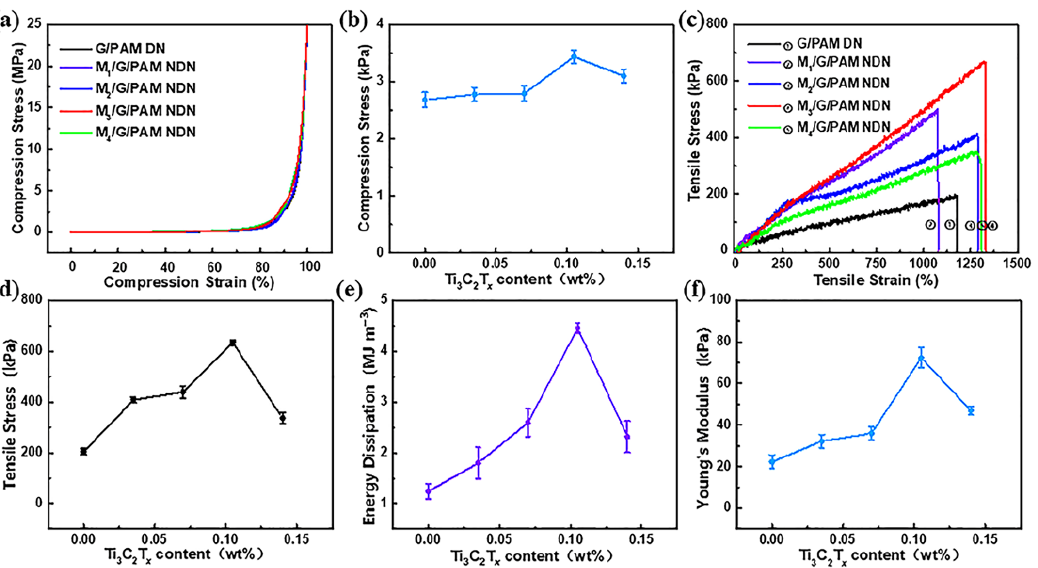
Figure 2. Comparison of ( a ) compressive stress–strain curves, ( b ) compressive strength (90% compression rate), ( c ) tensile stress–strain curves, ( d ) tensile strength, ( e ) energy dissipation and ( f ) Young’s modulus with different contents of Ti 3 C 2 T x . Table 2. The mechanical properties of G/PAM DN hydrogel and M 3 /G/PAM NDN hydrogel. Hydrogel